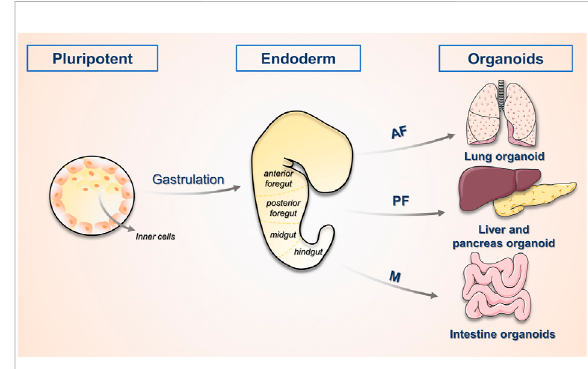
FIGURE 1 The process of organogenesis. The physiological process of human embryonic development begins with the oosperm, which dividesseveraltimestoformtheMorulaandthendevelopsintothe blastocyst. The inner cell mass within it serves as the early embryonic stem cells and has developmental omnipotence. The ectoderm, mesoderm and endoderm form various tissues and organs, this process is called organogenesis. The study of